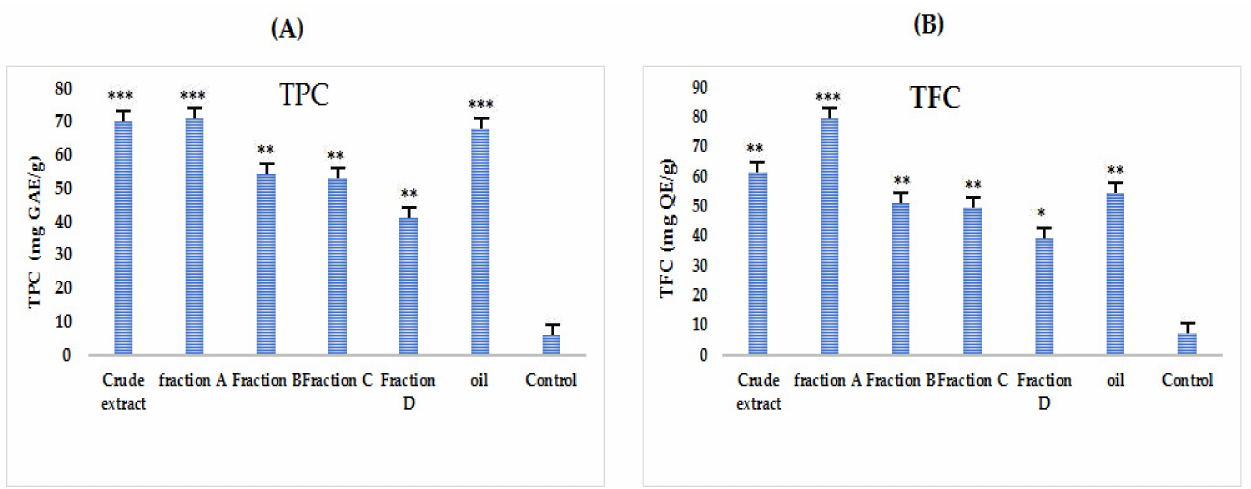
Figure 2. Total phenolic ( A ) and total flavonoids ( B ) contents in different tested samples (crude extract, purified fractions, and oil) of A. articulata . ( A ) TPC expressed as gallic acid equivalents (mg GAE)/g dry plant sample; ( B ) TFC expressed as quercetin equivalents (mg QE)/g dry plant sample. The data is represented as Mean ± SEM, n = 3. Values are significantly different as compared to positive control * p < 0.05, ** p < 0.01, *** p <